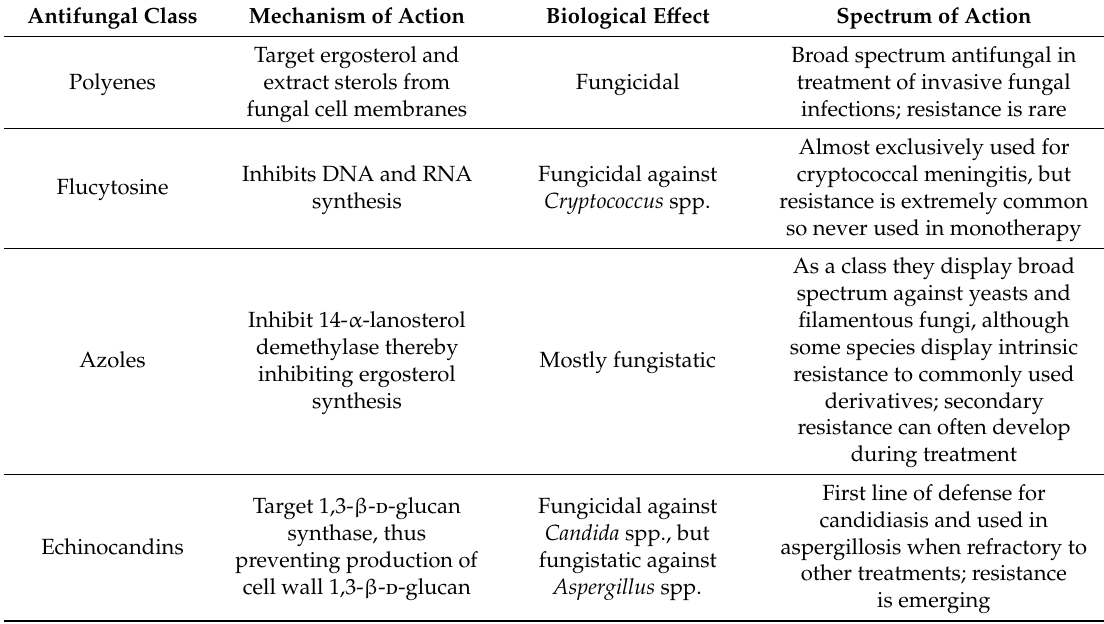
Table 1. The four main classes of clinically-used antifungal agents for the treatment of invasive fungal